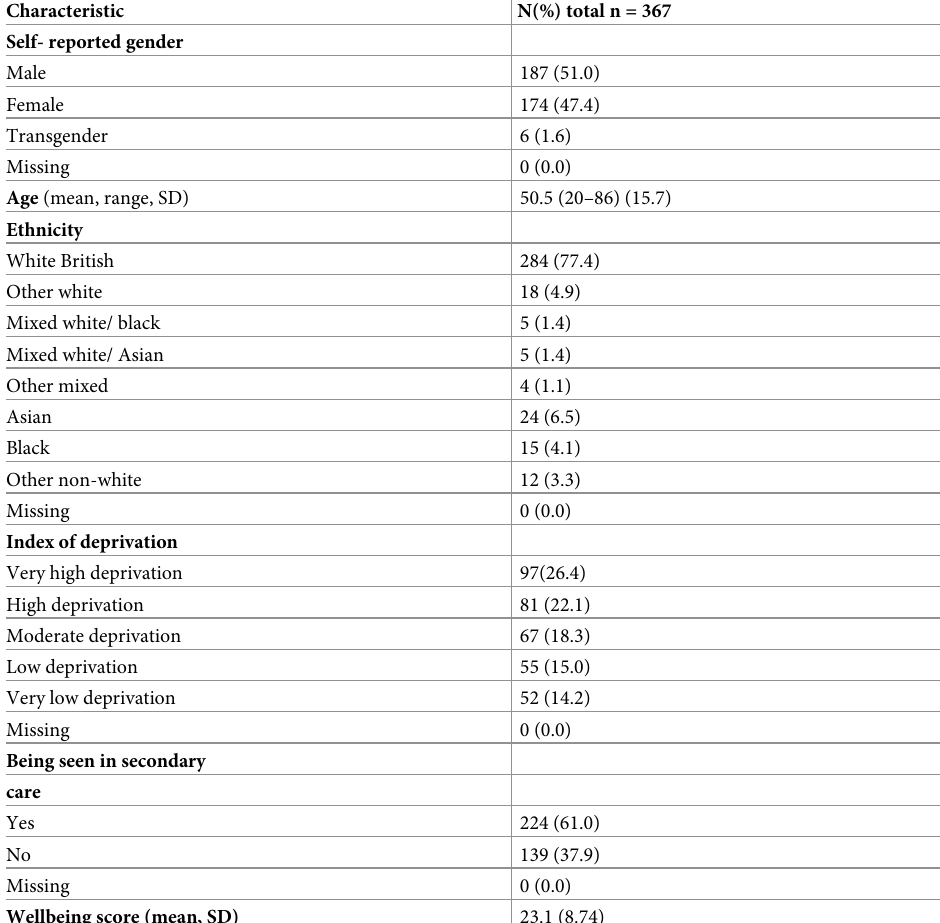
Table 1. Demographic characteristics of OWLS COVID-19 study SMI population during pandemic